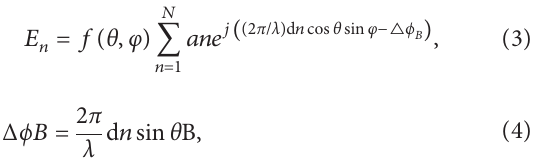
Figure 7: Schematic diagram of the linear array